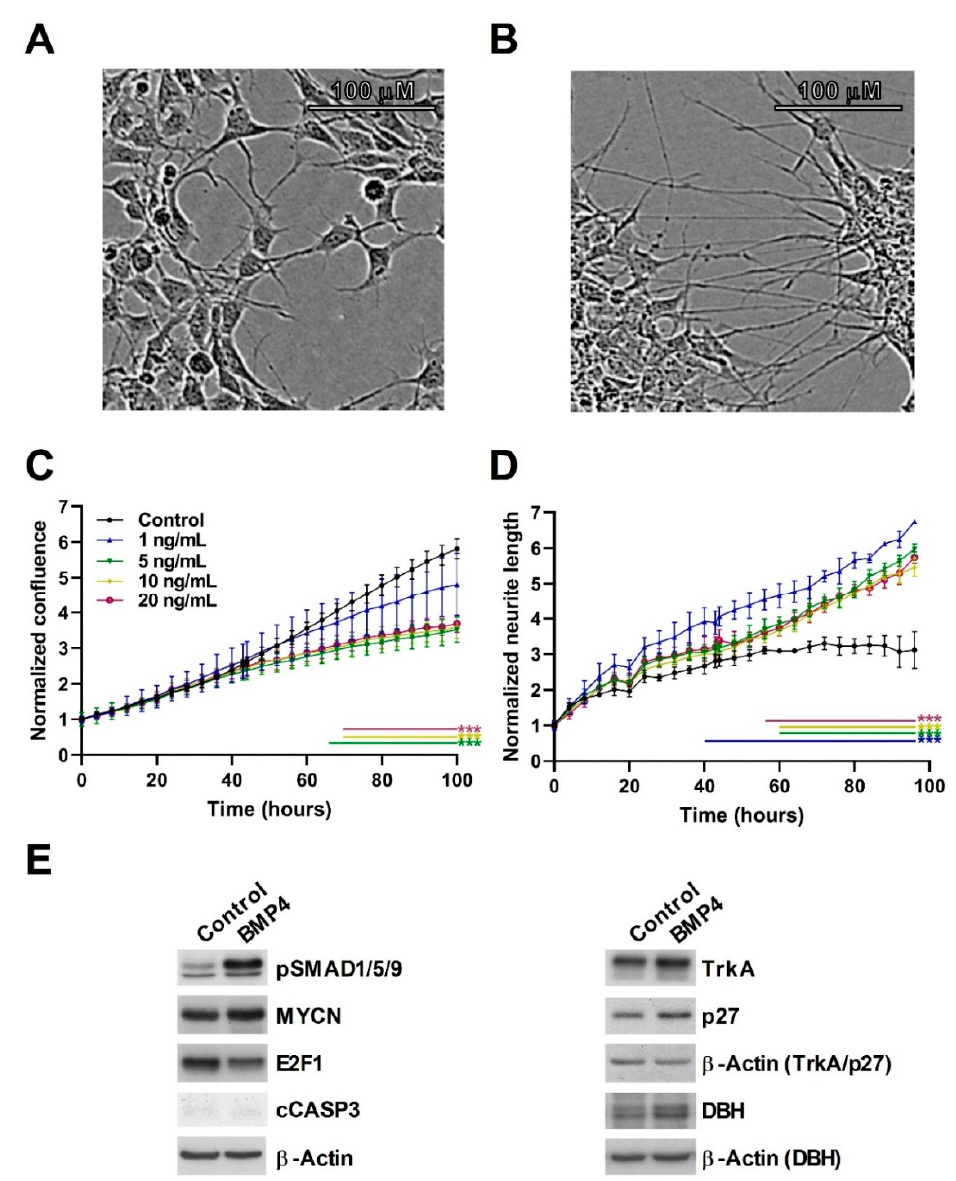
Figure 3. BMP4 treatment induces growth inhibition and phenotypic change in IMR32. Phase contrast image of ( A ) vehicle and ( B ) BMP4-treated IMR32 cells after 96 hours (10 ng/mL). ( C ) Normalized cell confluence, measured in triplicates, was significantly ( p < 0.01) reduced by BMP4 in concentrations above 5 ng/mL ( n = 3). ( D ) Significant changes ( p < 0.01) in normalized neurite length was observed after treatment with BMP4 at concentrations above 1 ng/mL ( n = 3). ( E ) Western blots showing protein expression and phosphorylation changes after 48-72 hours BMP4 treatment.